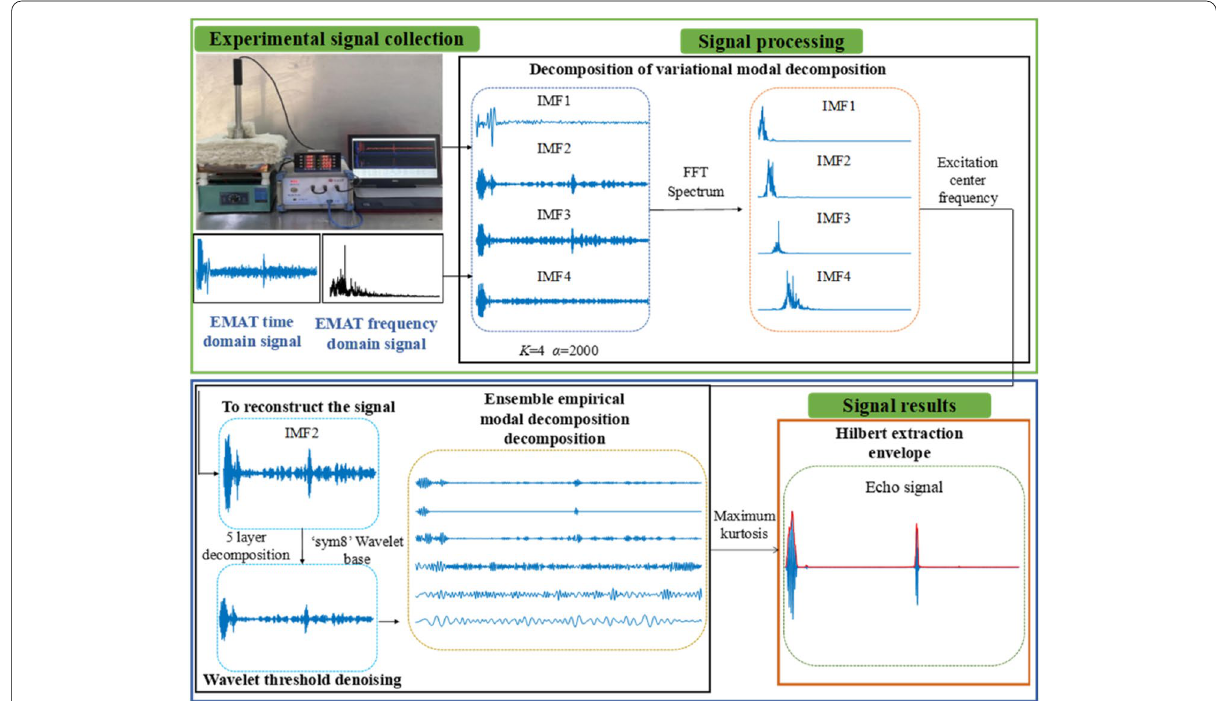
Figure 5 VWEE method